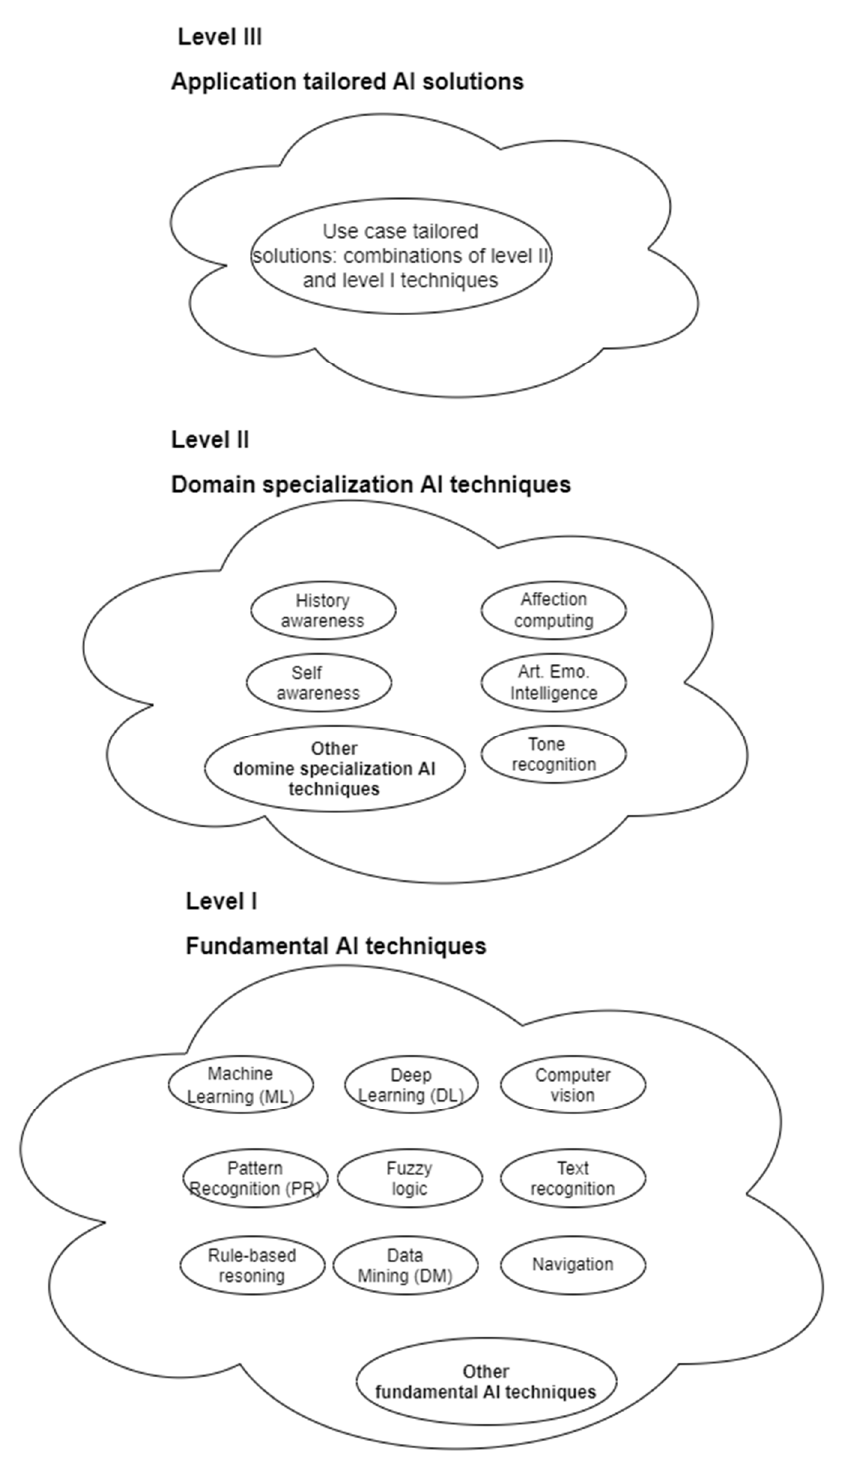
Figure 1. Hierarchy of specialization in AI tools and techniques.